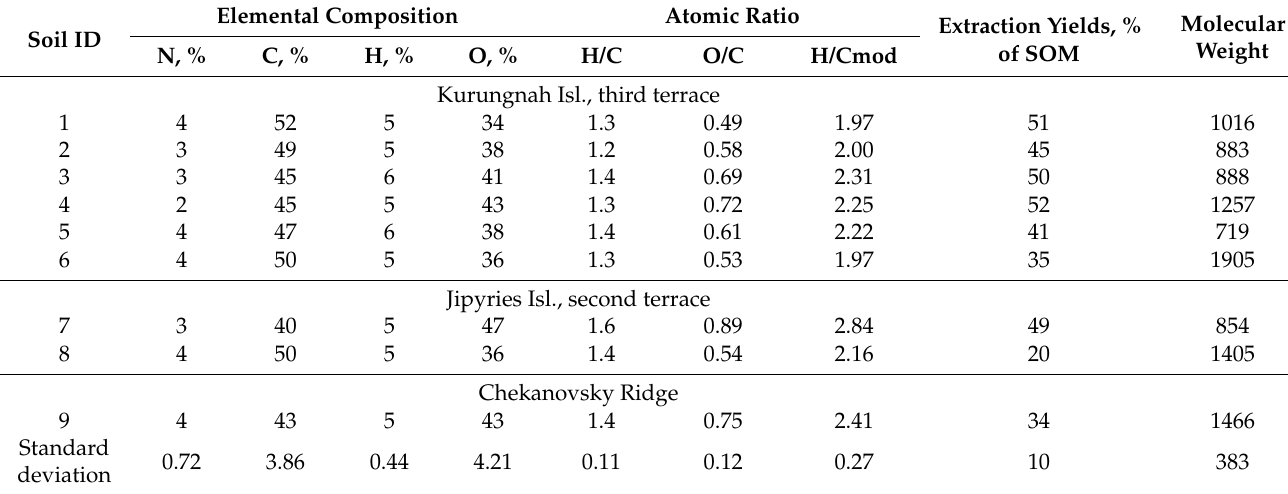
Table 3. Elemental composition of study HAs separated from soils of the Lena River delta. Soil IDs correspond to Table 1. Elemental Composition Atomic Ratio Extraction Yields, % Soil ID